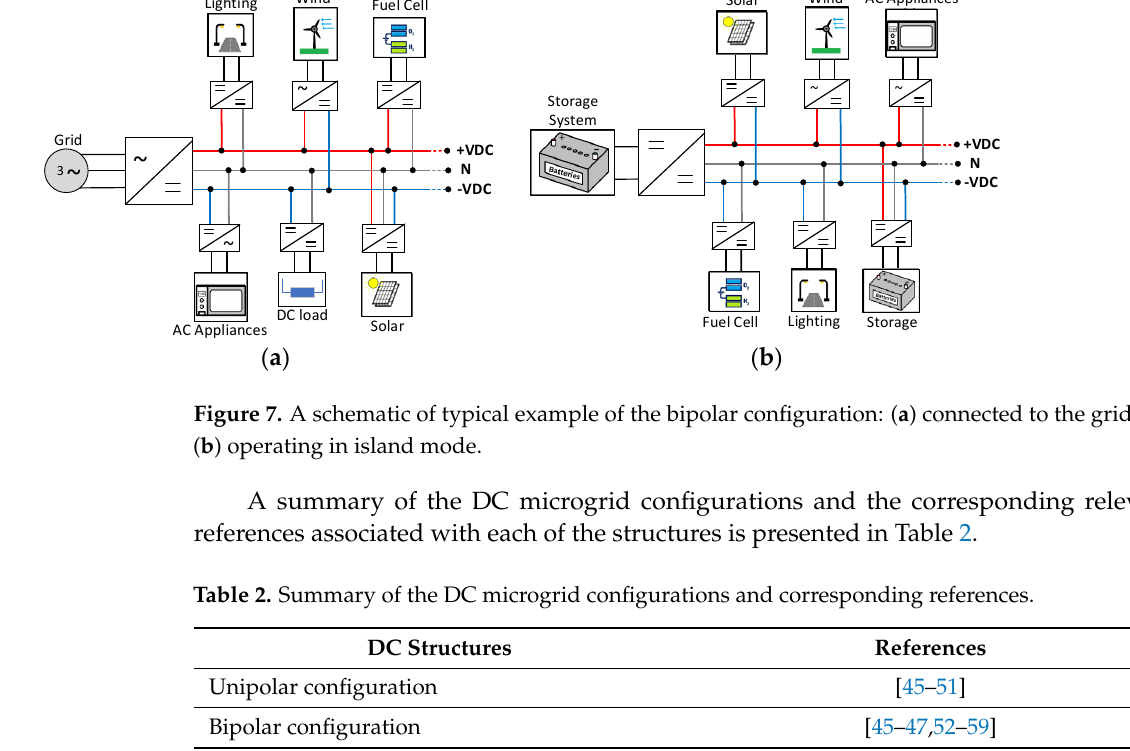
7 of 21 Figure 6. A schematic of typical example of the unipolar configuration: ( a ) connected to the grid and ( b ) operating in island mode. •